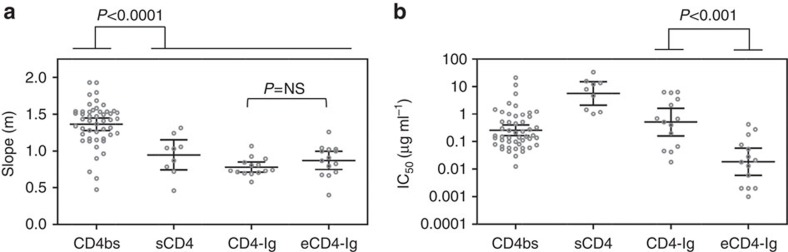
Slope and IC50 characteristics of CD4 immunoadhesins.Neutralization slopes (a) and IC50s (b) of the CD4bs bnAbs combined and CD4 immunoadhesin reagents sCD4, CD4-Ig and eCD4-Ig. Slope and IC50 values for CD4bs bnAbs and sCD4 are from Fig. 2 and reproduced here for ease of comparison. Slopes for CD4-Ig and eCD4-Ig were estimated from published IC50 and IC80 values42 using equation (6) (Methods). Thus, slopes were only estimated for a subset of Envs (n=14) where discrete IC50 and IC80 values were reported. Bars represent geometric mean IC50 with 95% CI or mean slope with 95% CI and P value (one-way ANOVA) compares slopes of CD4bs bnAbs with sCD4, CD4-Ig and eCD4-Ig combined in panel a, all other P values are Student's t-test.